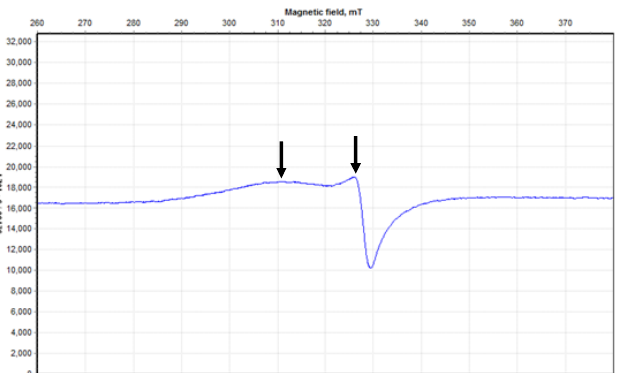
Fig. ESR spectrum of Cu(II)-AMT complex.